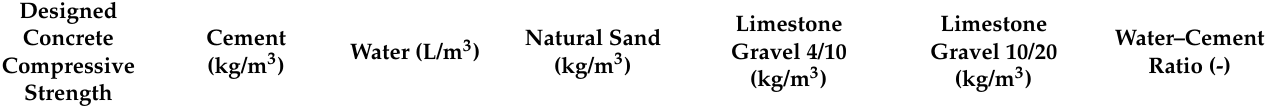
Table 3. Tested concrete mix recipes designed according to Bolomey